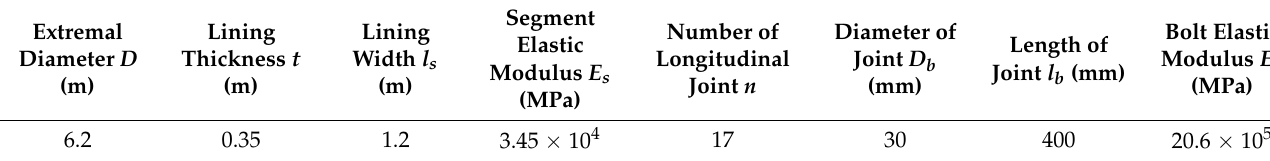
Figure 8. Finite element model of the existing tunnel. Table 2. Tunnel parameters of Shanghai Metro Line 9.